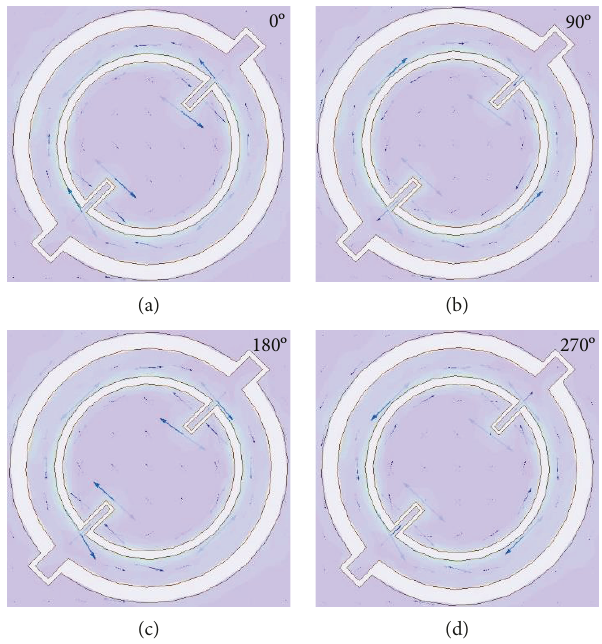
Figure 4: The current distribution for di ff erent phase angles at